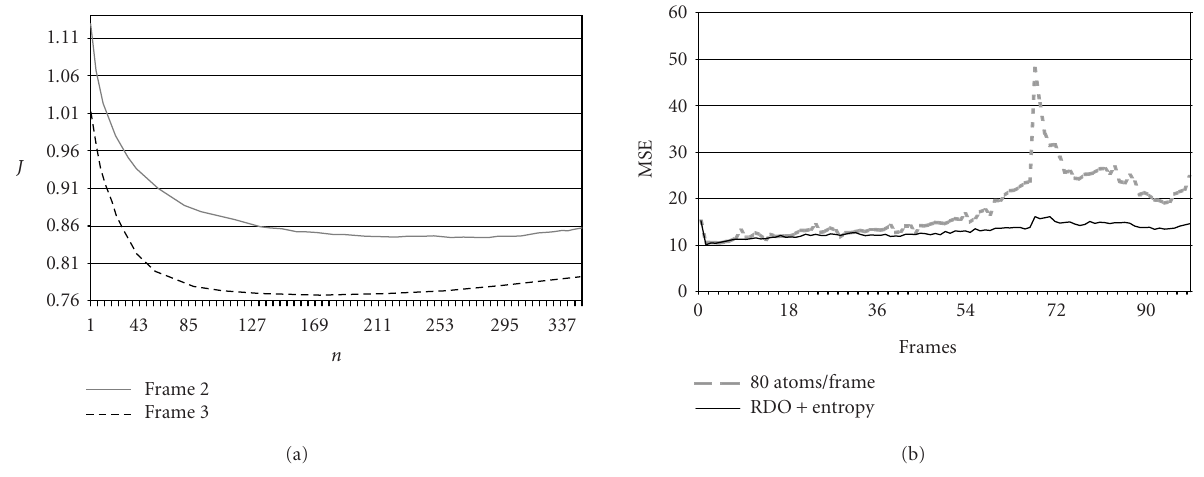
Figure 5: (a) RD optimization: J ( n ) for two frames of Stefan. (b) MSE for the first 100 frames of News coded with and without RD opti-